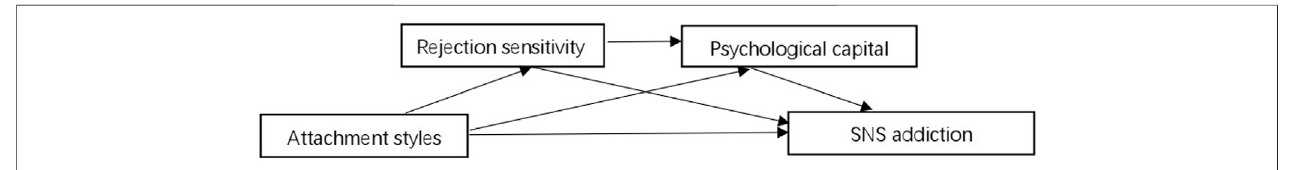
FIGURE 1 | The hypothesized